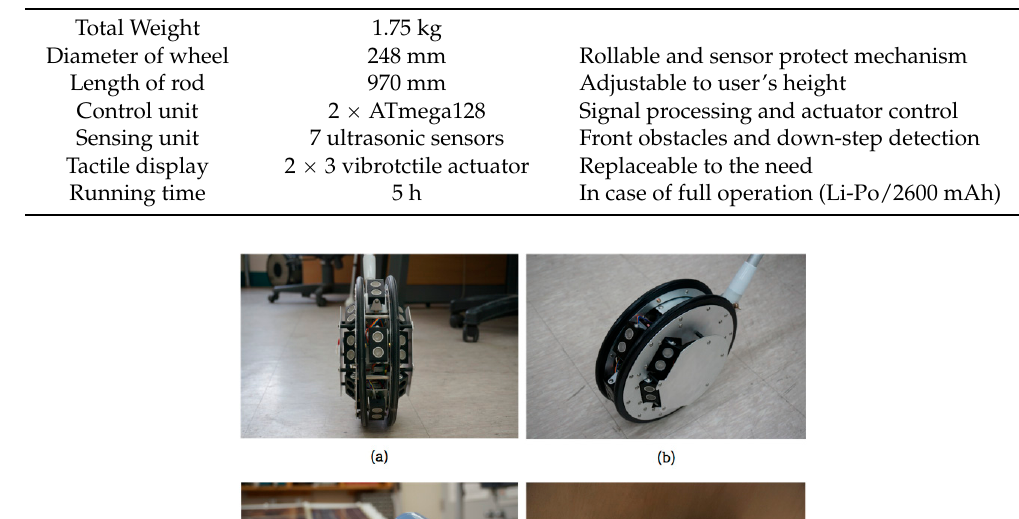
Table 8. Specification of light-weight ETA.